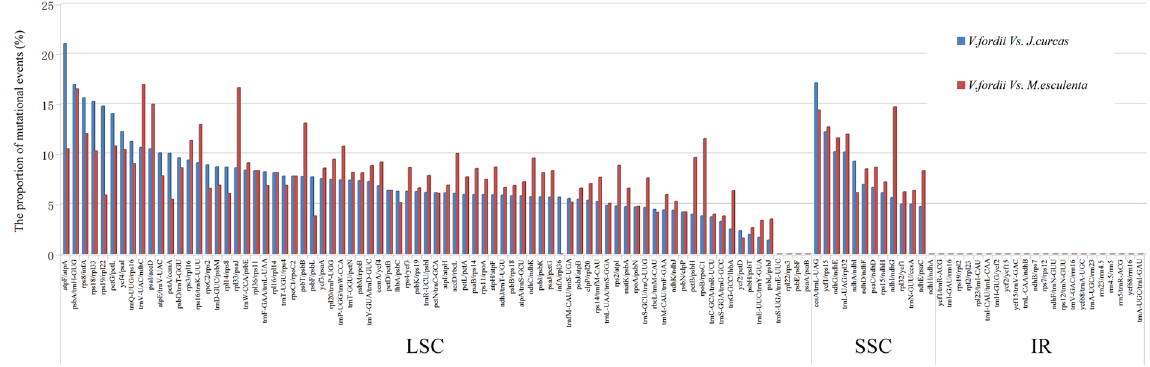
Figure 2. The variation analysis within intergenic spacer (IGS) regions between V. fordii and J. curcas or M. esculenta .